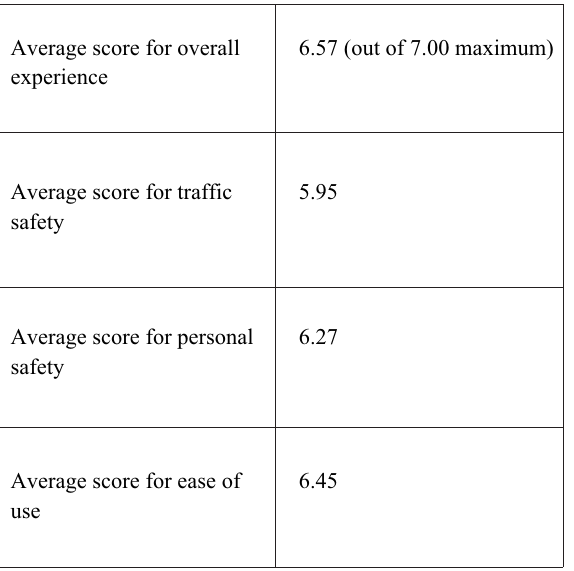
Table 1. Pedestrian feedback on safety and